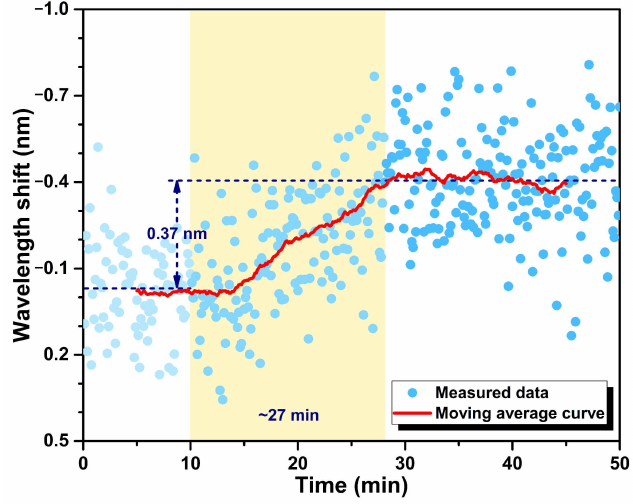
Figure 8. Dynamic response of the resonant wavelength shift of the HGMS with LC sensitization to the low concentration variation from 0 to 1 ng/mL.